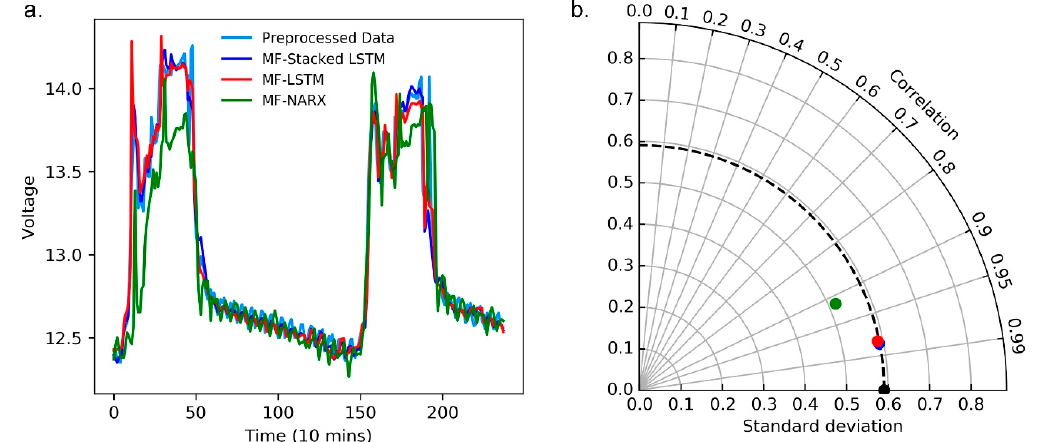
Figure 8. Curve diagram and Taylor diagram of the predictors with the MF for the operating voltage. ( a ) The curve diagram of the predictors; ( b ) The Taylor diagram of the predictors.